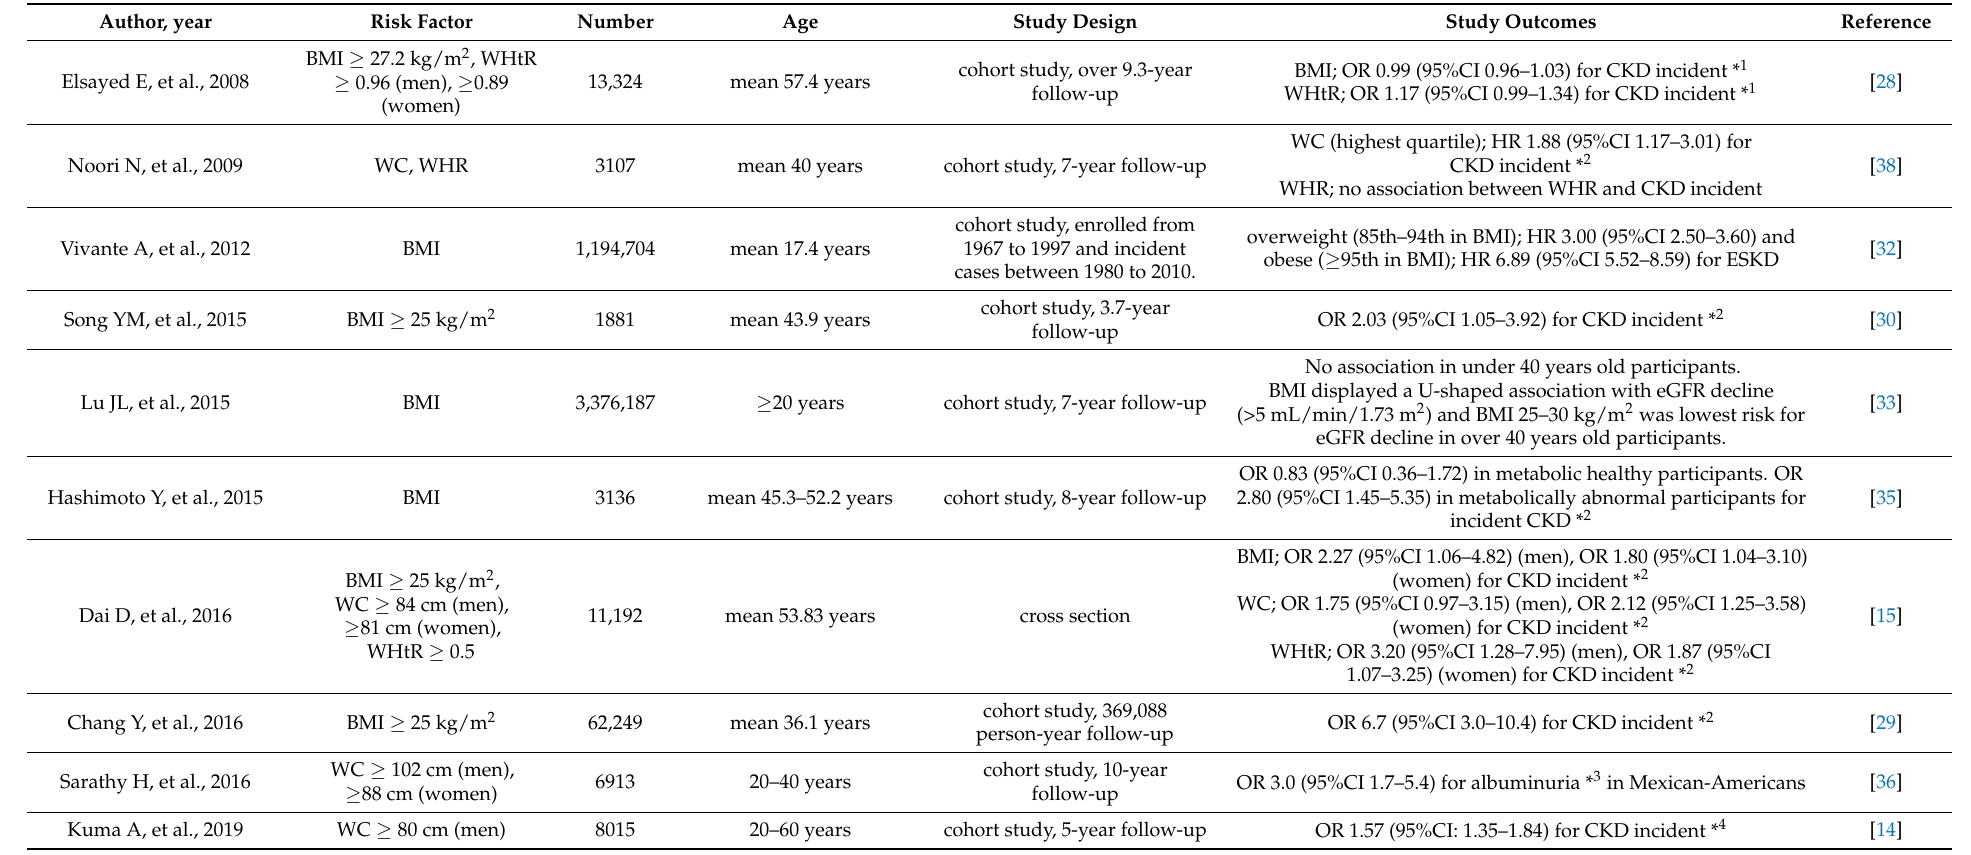
Table 1. Outcomes of previous studies focused on risk of obesity for chronic kidney disease in young- and middle-aged